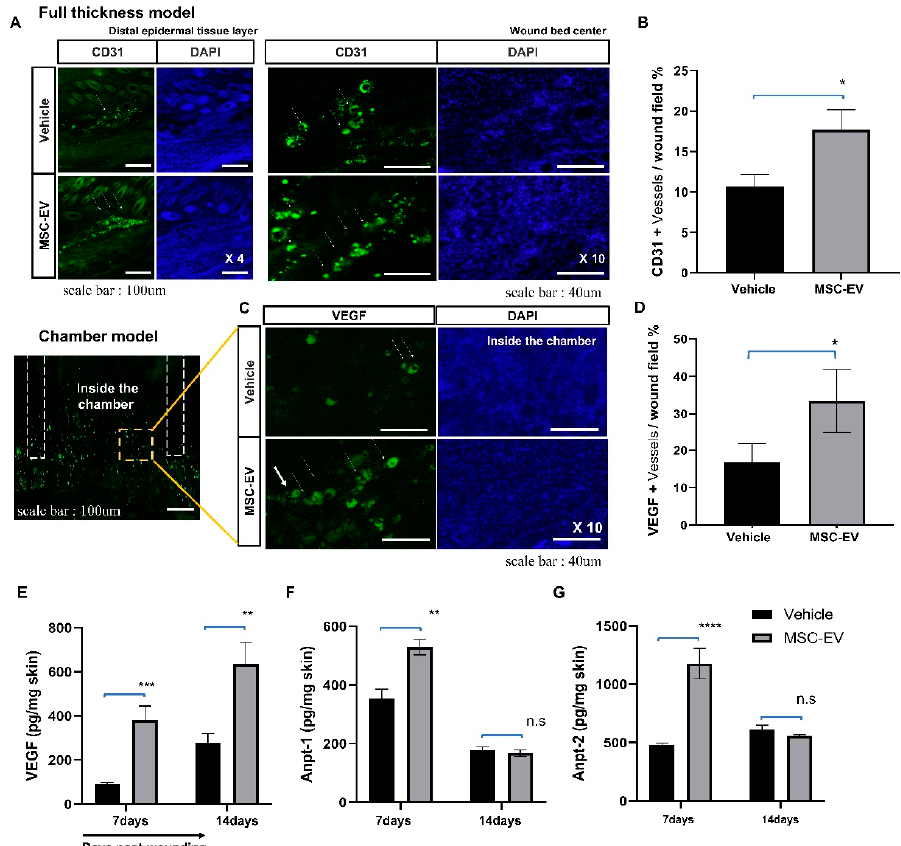
Figure 5. Effects of EVs on angiogenesis in the chamber wound model. ( A ) Immunohistochemical staining for CD31 (a marker of vascular structure) in the dermis and neovascularization sites at the center of the wound. Arrow heads indicate CD31 + vessels. Left panel, scale bar: 100 µ m; Right panel, scale bar: 40 µ m ( B ) Quantification of CD31 + cells and vessels per 20 × field in the wound bed at the center of wounds treated with the vehicle or MSC-EVs collected on day 7 post-wounding. ( C ) On day 14, vascular endothelial growth factor (VEGF)-positive blood vessels were observed in MSC-EV-injected wounds. Arrow heads indicate VEGF + vessels. Scale bar: 40 µ m ( D ) Quantification of VEGF + cells and vessels per 20 × field in the wound bed at the center of wounds treated with the vehicle or MSC-EVs collected on day 14 post-wounding. ( E – G ) ELISA analyses of angiogenesis protein expression in MSC-EV-treated wound and vehicle groups. Each sample was assessed in duplicate, and the analysis was conducted thrice independently. Error bars indicate the mean ± SD. p -values were calculated using an unpaired Student’s t -test. **** p < 0.0001, *** p < 0.001, ** p < 0.01, and * p < 0.05; ns: p > 0.05, not